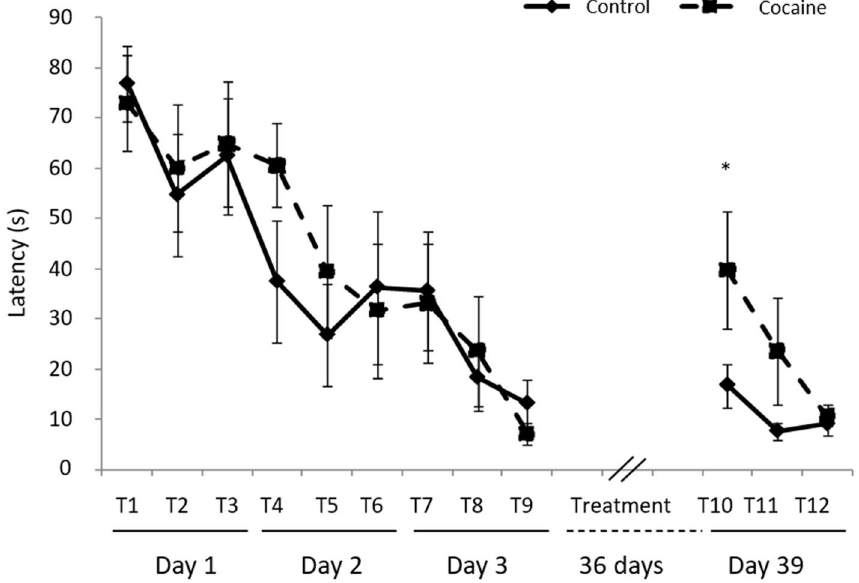
Figure 1. Morris water maze test performance adapted to study memory retrieval in animals from all groups. *p < 0.05 vs. cocaine group trial 9 (n =